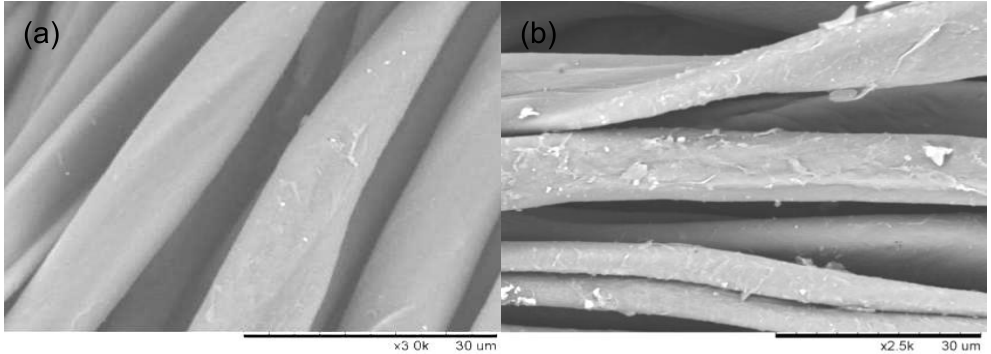
Figure 10. Scanning electron microscopy of cotton fabrics: ( a ) Before modification; ( b ) after modification.